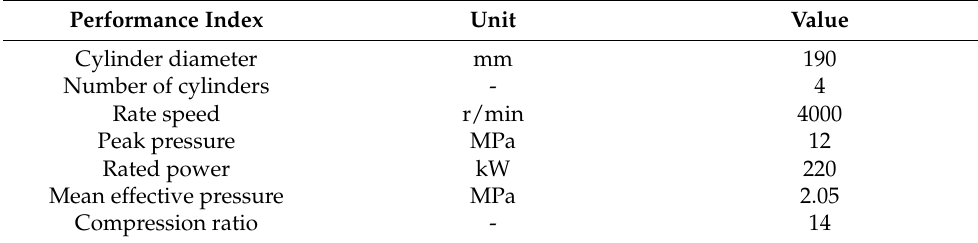
Figure 1. Simulation model of the entire diesel engine. Table 1. Key parameters for diesel engines.